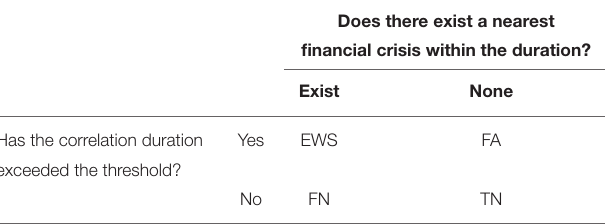
TABLE 1 | The classification matrix used in this study.